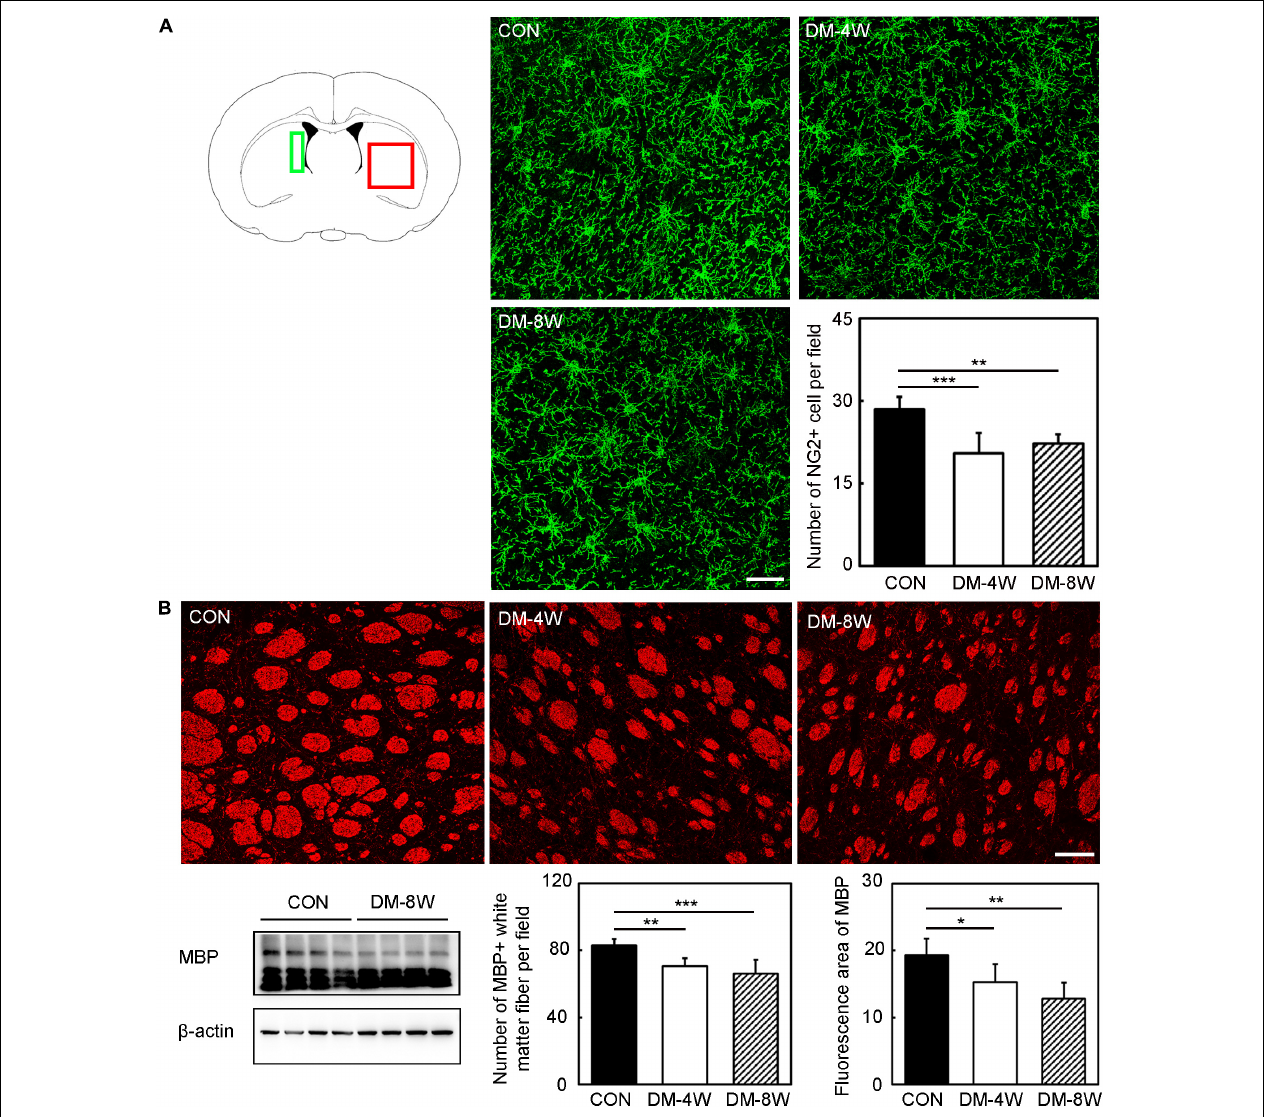
FIGURE 6 | The number of OPC and MBP expression decreased in diabetic mice . (A) Immunofluorescent images of NG2 (green) and bar graph of NG2 quantification in the control, DM-4W and DM-8W groups. Scale bar = 50 µ m. The green box indicates the location of the NG2 immunofluorescence staining pictures collected by confocal microscope. The red box indicates the location of the MBP immunofluorescence staining pictures collected by confocal microscope. (B) Immunofluorescent and Western blot images of MBP and bar graphs of MBP quantification in the control, DM-4W and DM-8W groups. Scale bar = 100 µ m. Data are mean ± SD , n = 6 per group, * p < 0.05, ** p < 0.01, *** p < 0.001, DM-4W or DM-8W vs.